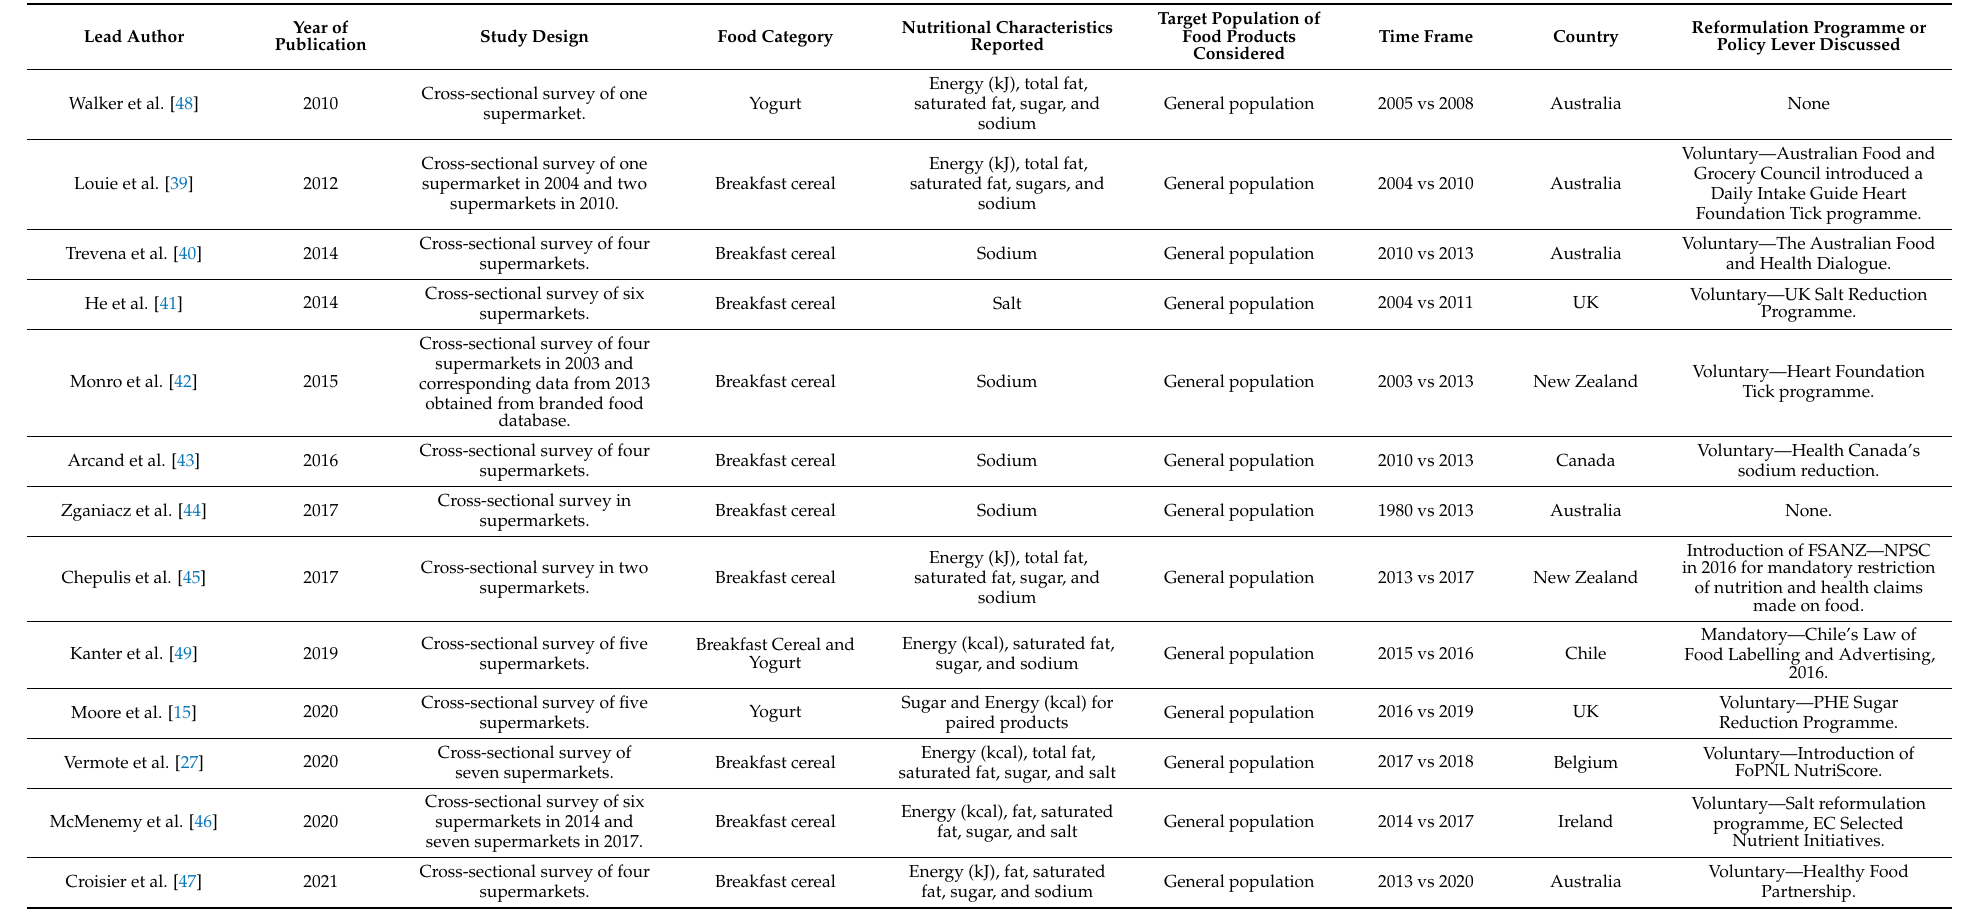
Table 2. Characteristics of 13 studies investigating the reformulation of breakfast cereals and yogurts included in this